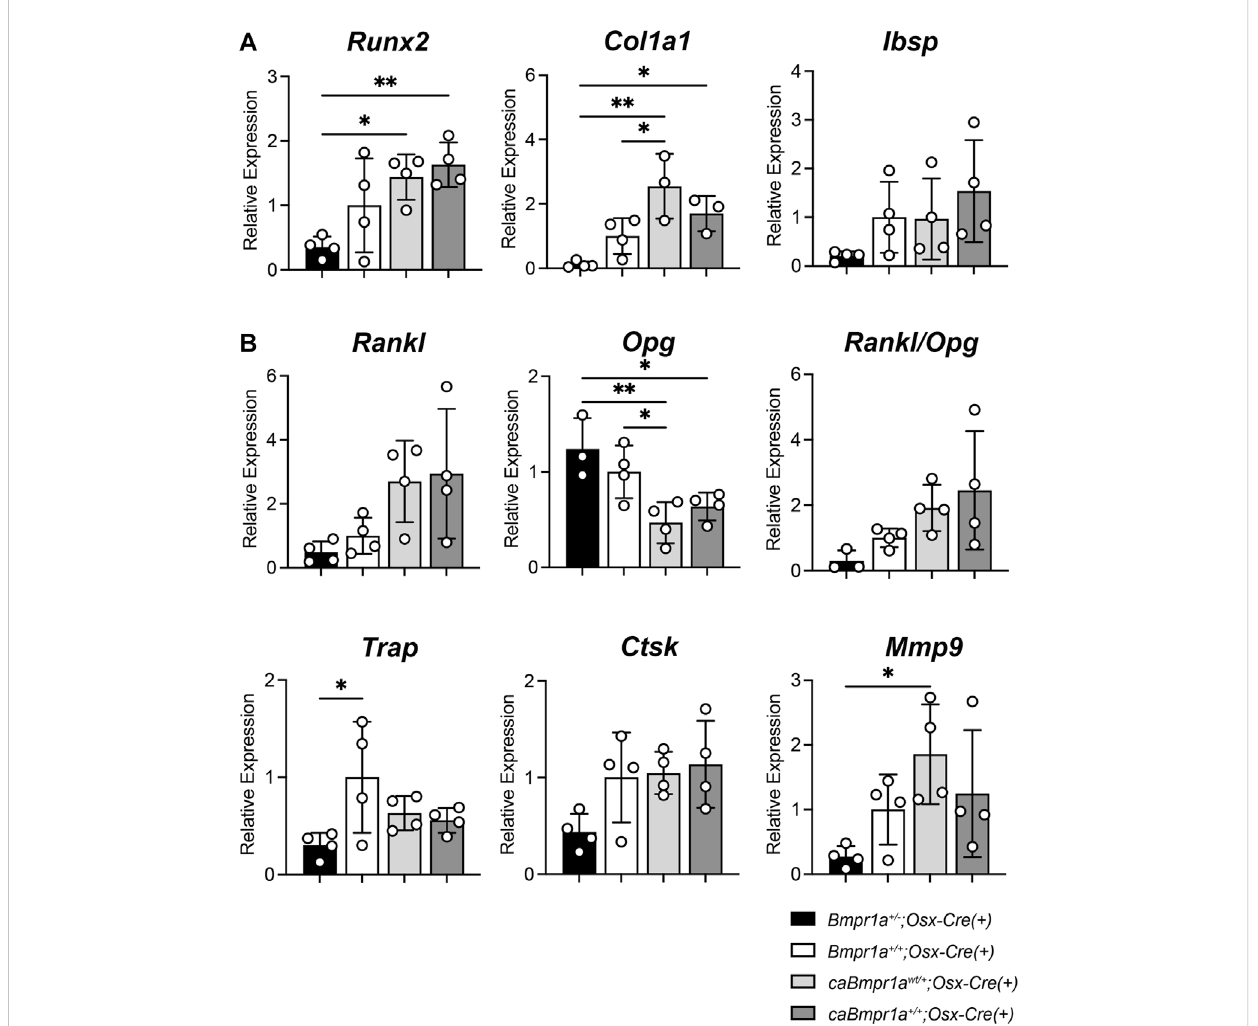
FIGURE 5 Gene expression for bone formation and bone resorption markers in the male mouse tibia at 12 weeks of age. (A) Bone formation marker genes ( Runx2, Col1a1, Ibsp ) were analyzed. (n = 4 each group). (B) Bone resorption marker genes ( Rankl, Opg, Trap, Ctsk, Mmp9 ) were analyzed (n = 4 male for each group). ** p < 0.01 and * p <